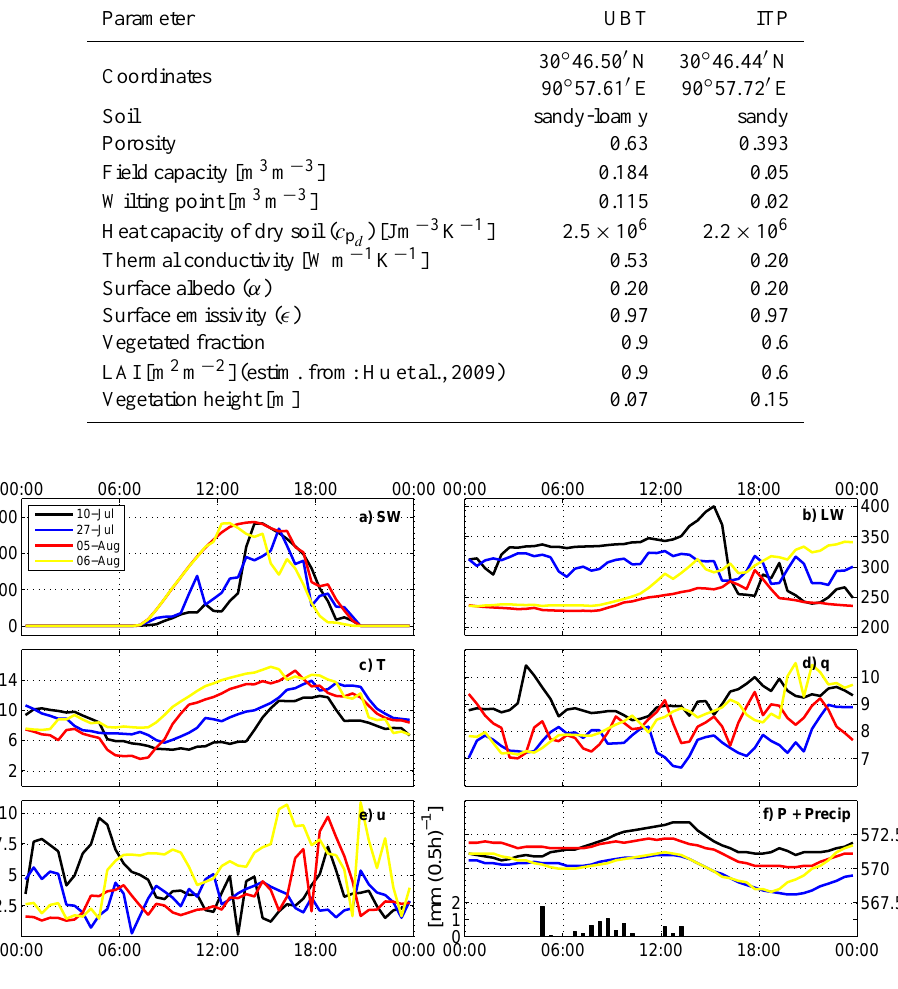
Fig. 3. Same as Fig. 2, but with forcing data measured at ITP. Precipitation at ITP was measured daily and for the purpose of this study distributed to 30 minute intervals according to the recorded rain fall at